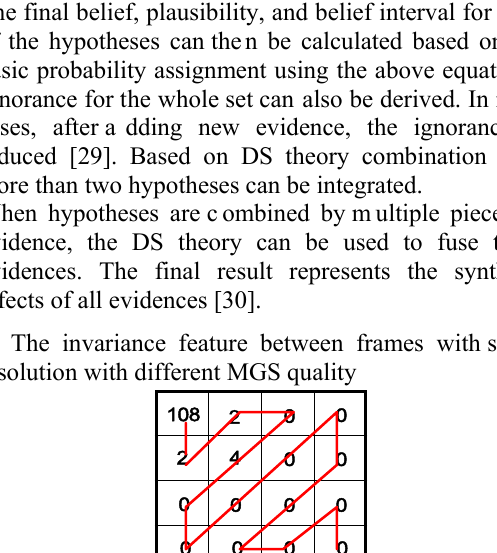
Figure 2. The relation between Bel and Pls